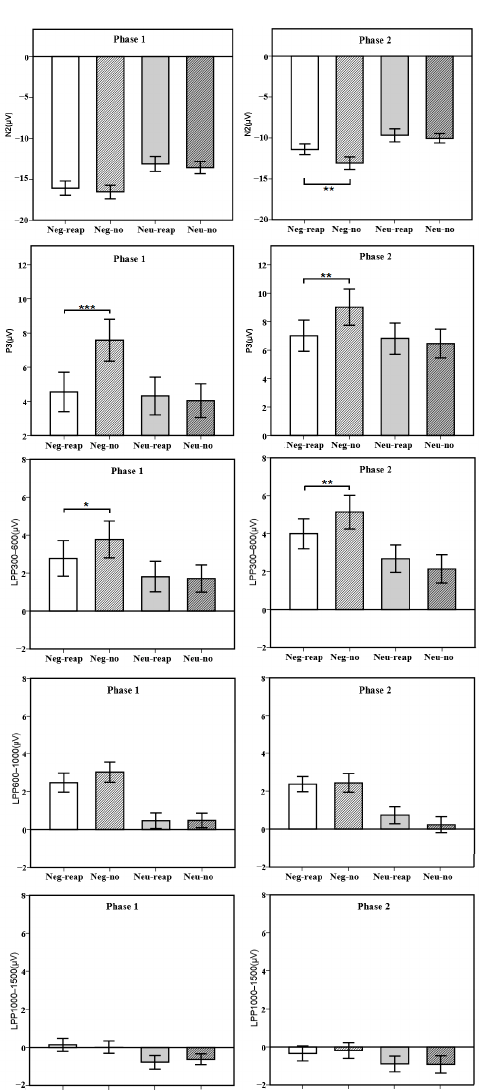
Figure 2. Average amplitudes of different components between different conditions in phase 1 and phase 2 (N2, P3, LPP300–600, LPP600–1000, and LPP1000–1500). * p < 0.05; ** p < 0.01; *** p < 0.001. Neg-reap = Negative reappraisal; Neg-no = Negative no-regulation; Neu-reap = Neutral reappraisal; Neu-no = Neutral no-regulation. Error Bars represent standard error.